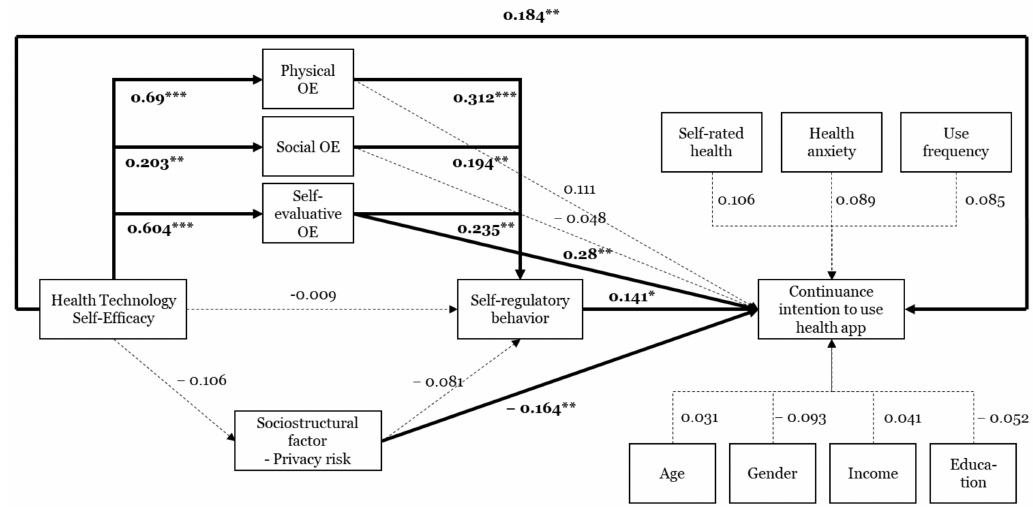
Figure 3. Results of structural model analysis. * p < 0.05. ** p < 0.01. *** p < 0.001. OE: Outcome